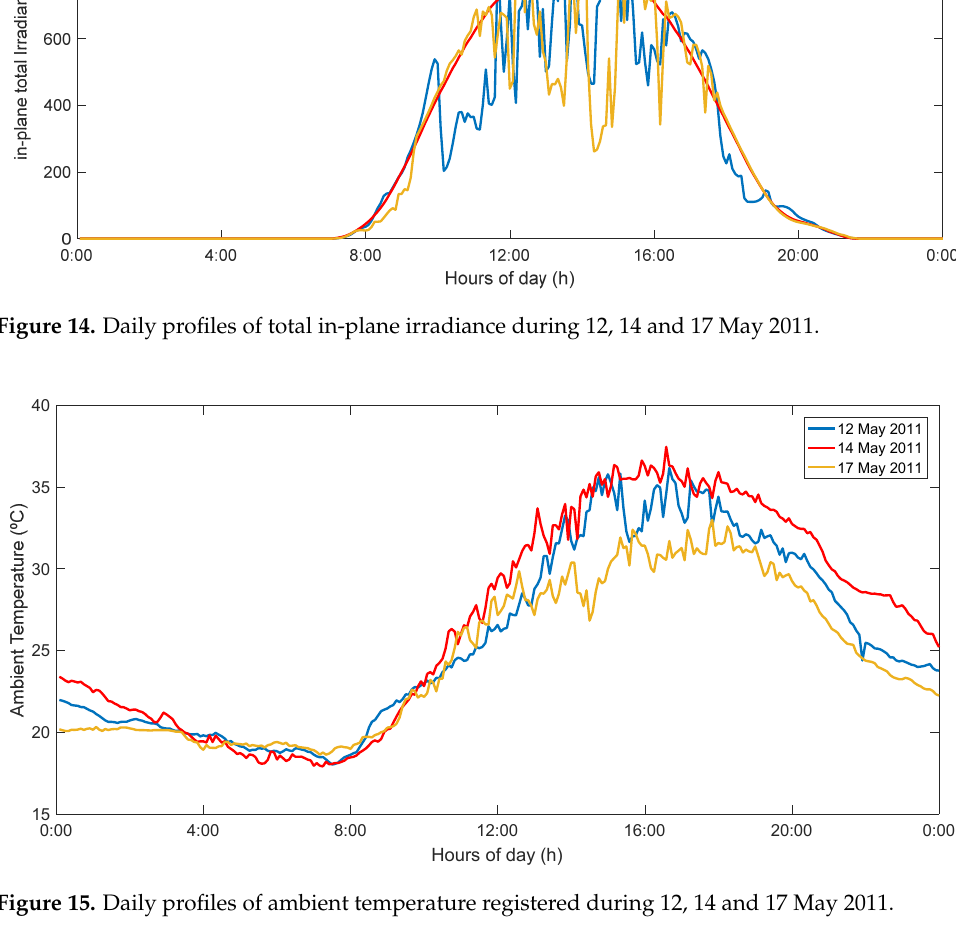
Figure 15. Daily profiles of ambient temperature registered during 12, 14 and 17 May 2011.